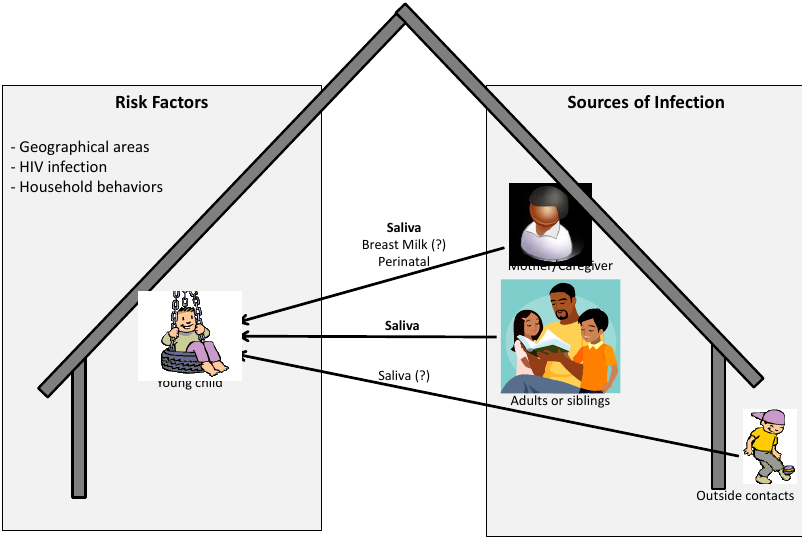
Figure 1. Pictorial representation of possible sources and risk factors associated with acquisition of KSHV infection by children in endemic